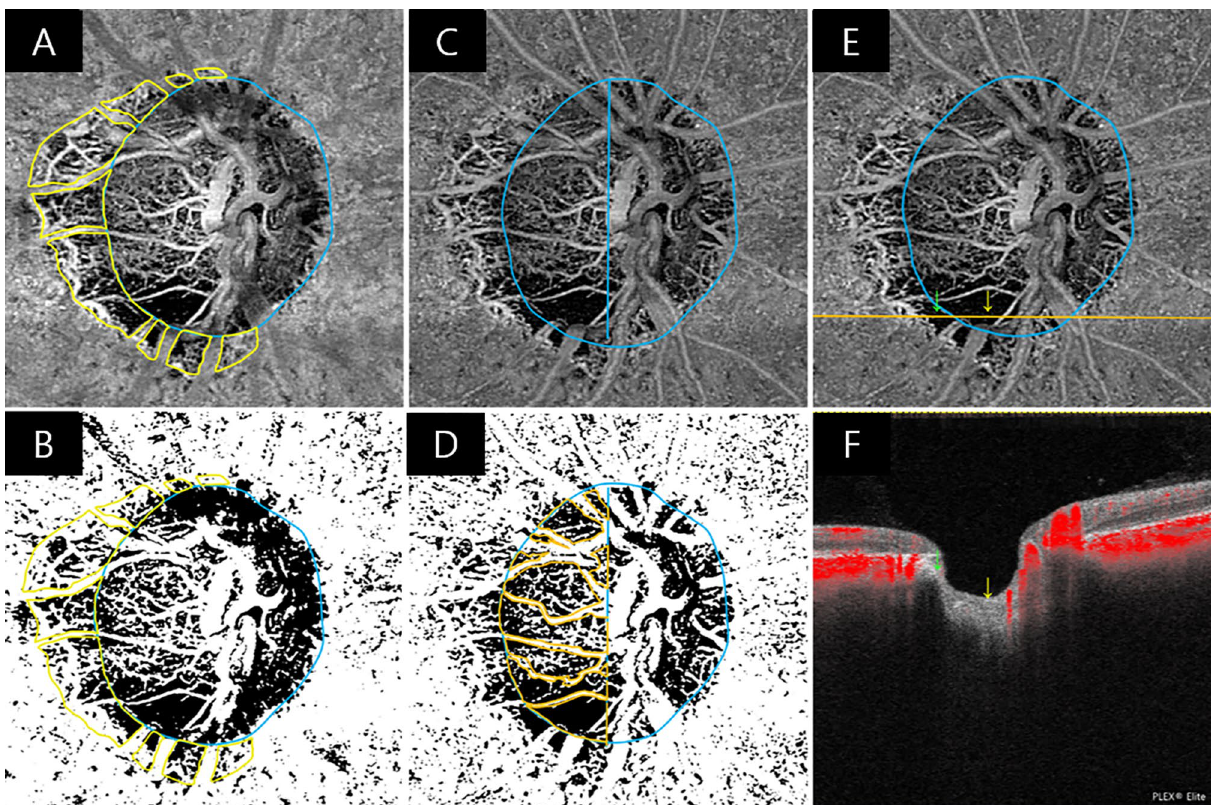
Figure 1. Measurements of parapapillary choroidal vessel density (VD) and intradisc VD and confirmation of the presence of choroidal microvascular dropout (CMvD), and optic disc microvascular dropout (MvD) in a primary open-angle glaucoma (POAG) eye with CMvD using swept-source optical coherence tomography angiography (SS-OCTA). ( A ) The blue ellipse line shows the optic nerve head (ONH) margin. The yellow outline indicates the β-parapapillary atrophy (β-PPA) margins, excluding large retinal vessels, which are applied to the SS-OCTA choroidal layer en-face image. The selected area of interest, excluding large retinal vessels, within the β-PPA was converted to a region of interest (ROI), ( B ) then applied to the 8-bit binary slab of an SS-OCTA choroidal layer en-face image. ( C ) The ROI within the ONH, excluding large retinal vessels, was manually demarcated on a whole-signal mode ONH en-face image. ( D ) These areas of interest were used to measure the intradisc VD (orange outline) using the ImageJ software. ( E ) The presence of CMvD (green arrow) and optic disc MvD (yellow arrow) was detected ( F ) using a horizontal B-scan that showed loss of microvasculature signal in the prelaminar tissue and anterior portion of lamina